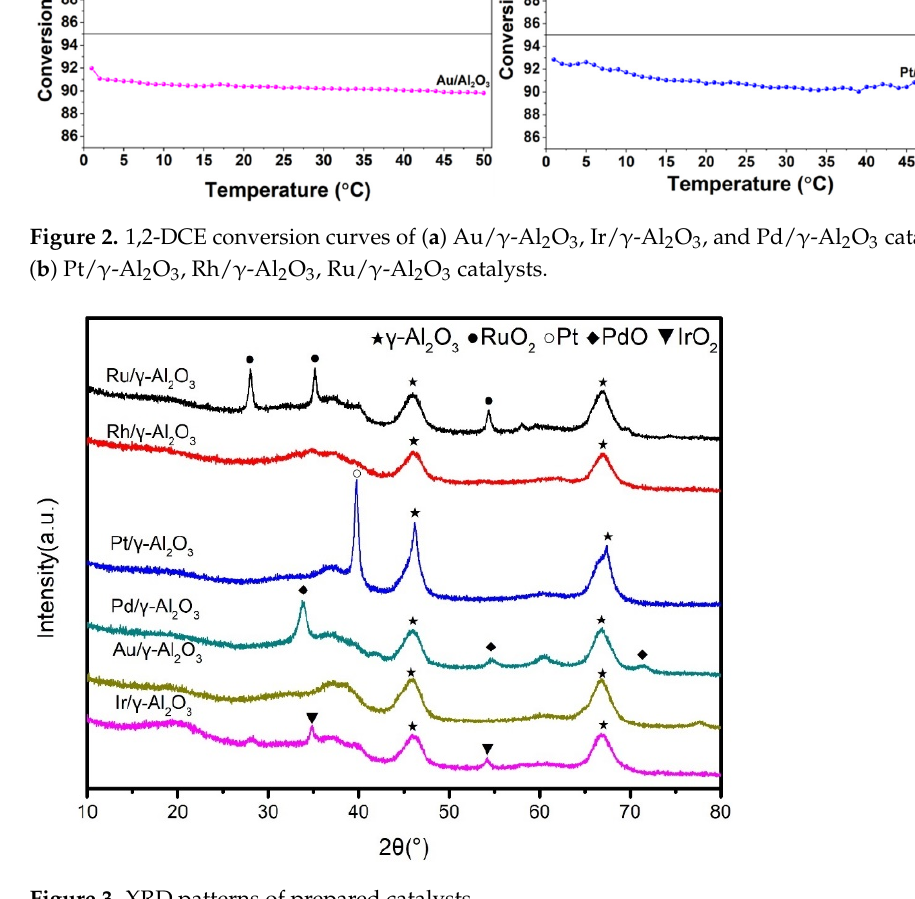
Figure 3. XRD patterns of prepared catalysts.